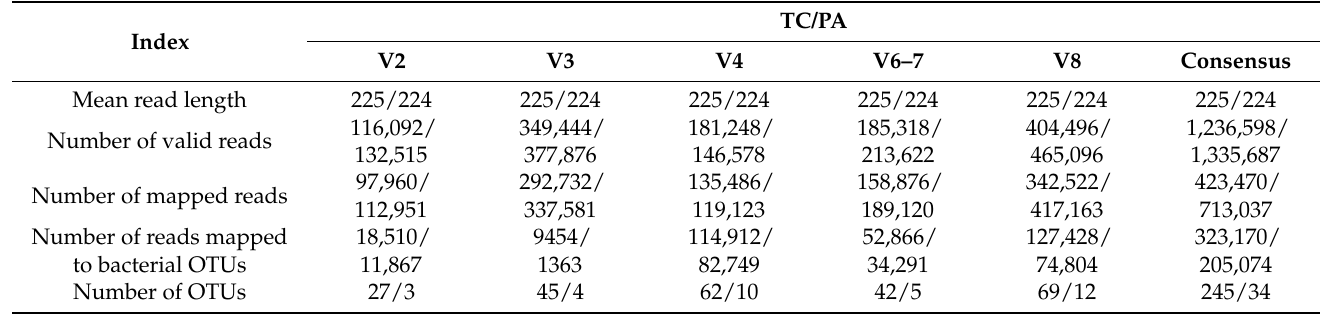
Table A2. Summary statistics 16S rRNA sequencing analysis of the in vitro tobacco control (TC) and post-antibiotic treatment shoots (PA)